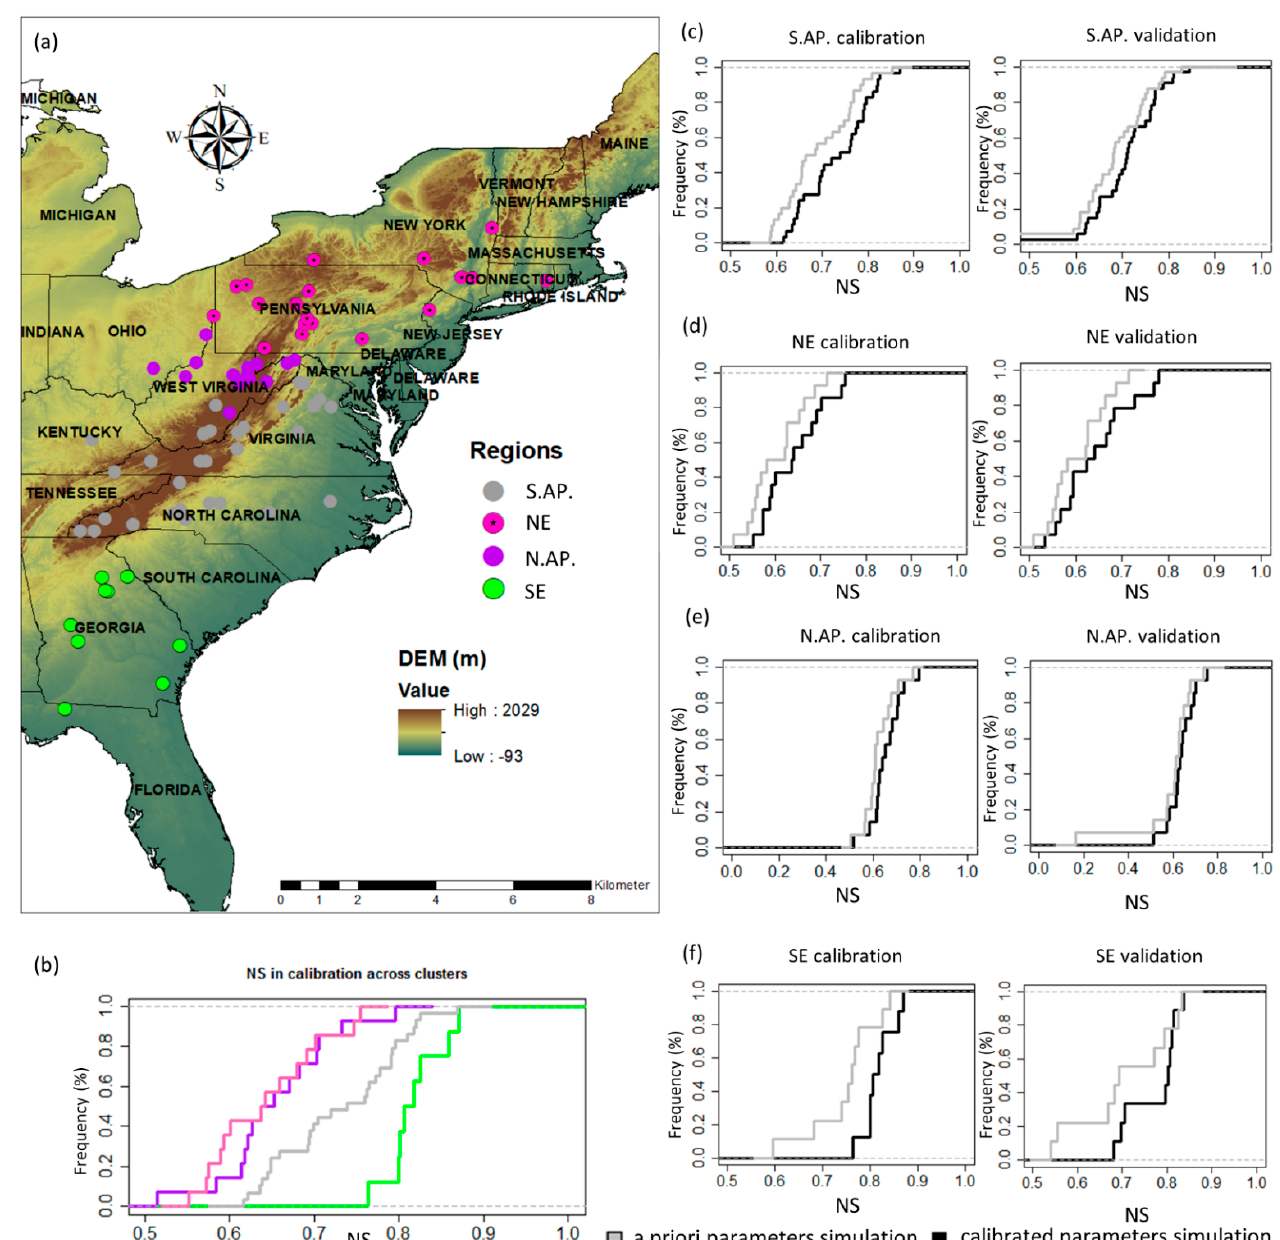
Figure 4. ( a ) Catchments regionalization according to Sawicz et al. (2011) and DEM, ( b ) comparison of Nash–Sutcliffe coefficients (NS) between regions in the calibration period using the cumulative distribution functions (CDFs), ( c ) CDFs of NS coefficients using a priori and calibrated parameters in S.AP., ( d ) in NE, ( e ) in N.AP. and ( f ) in SE. NE stands for north east, N.AP. stands for North Appalachian, S.AP. stands for south Appalachian, SE stands for south east. The NS coefficient was calculated at each study station using the observed and simulated discharges.